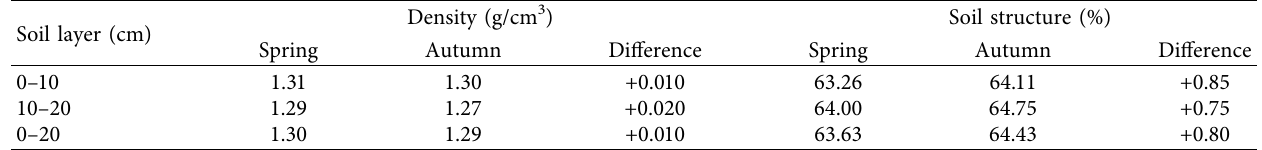
Table 6: Phytomeliorative effect of safflower on agrophysical indicators of dark chestnut soils. Soil layer